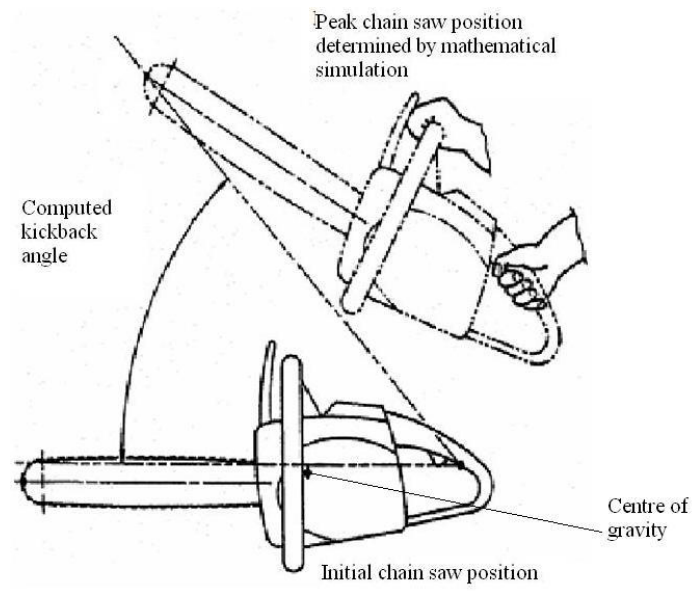
Figure 3. Computer simulation of chainsaw motion and calculation of kickback angle.